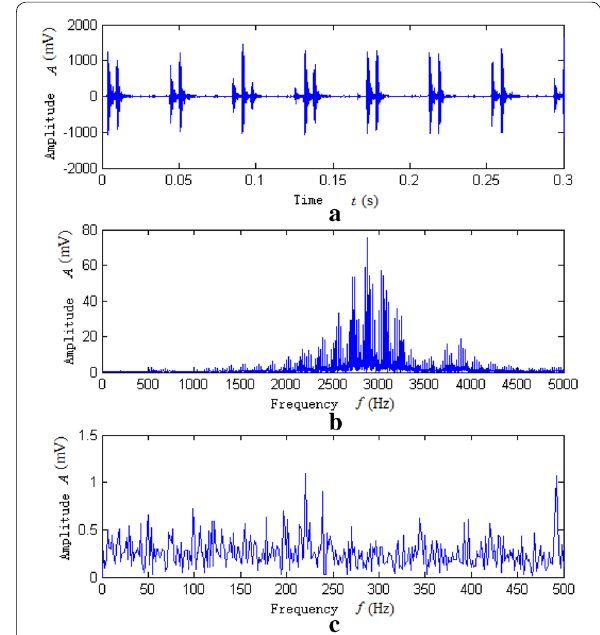
Figure 3 Inner race fault signal of N205: ( a ) time waveform, ( b ) FFT spectrum, ( c ) local spectrum